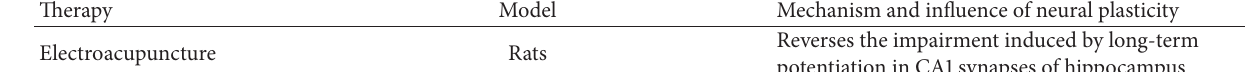
Table 2: Neural plasticity in the treatment of